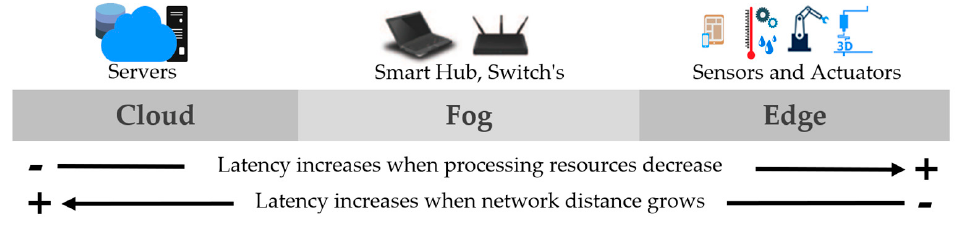
Figure 2. Resources and distance versus latency.